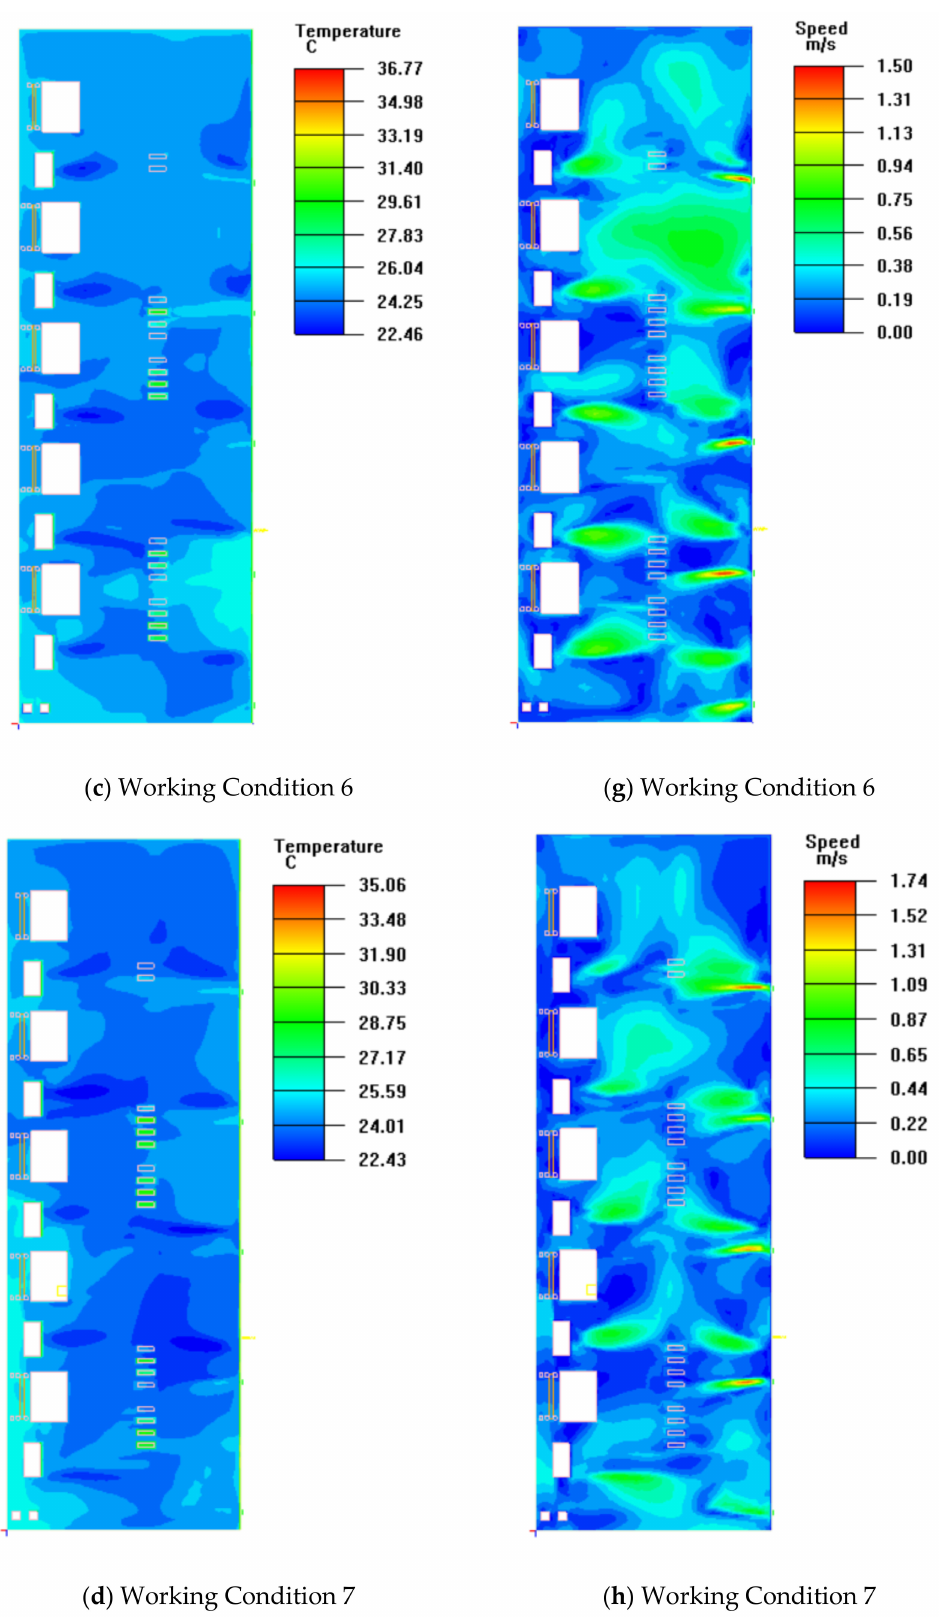
Figure 9. Temperature field and velocity field at a height of 1.6 under different working conditions (( a – d ) temperature field; ( e – h ) velocity